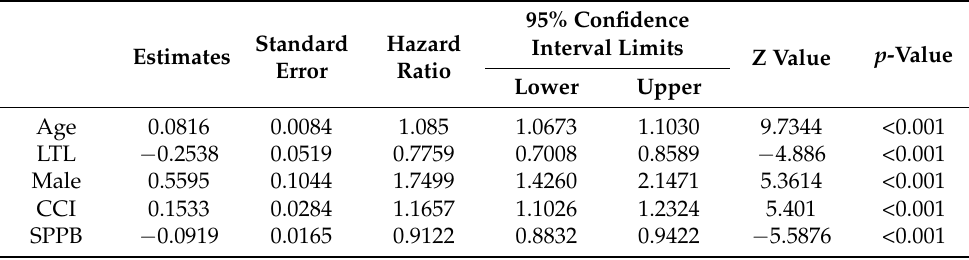
Table 5. Determinants of survival. Estimated semi-parametric Cox’s proportional hazards model for survival-time with episode splitting and weighed sample.